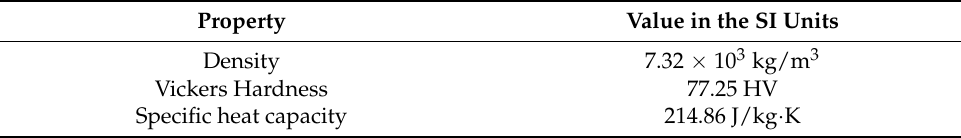
Table 3. Physical properties of the as-received galena